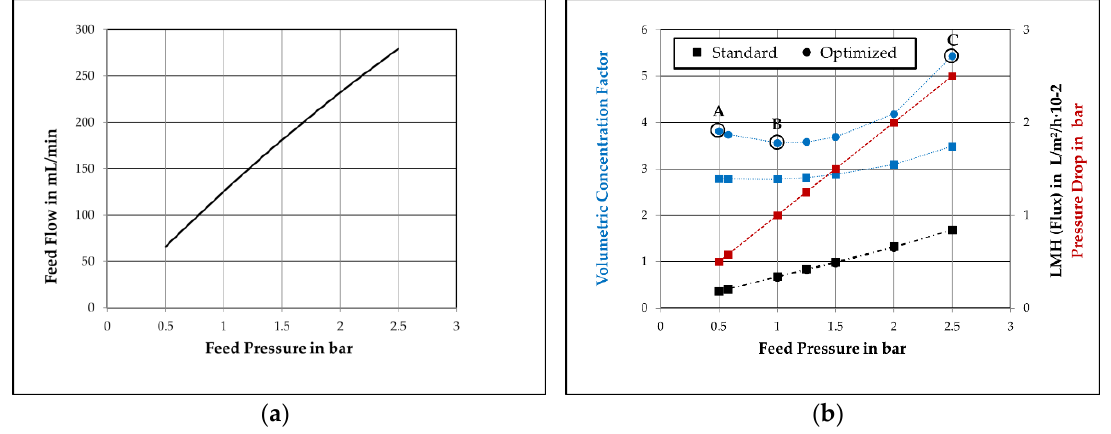
Figure 12. Calculation scenario: ( a ) Feed pressure vs. feed flow, ( b ) results based on pressure variation.